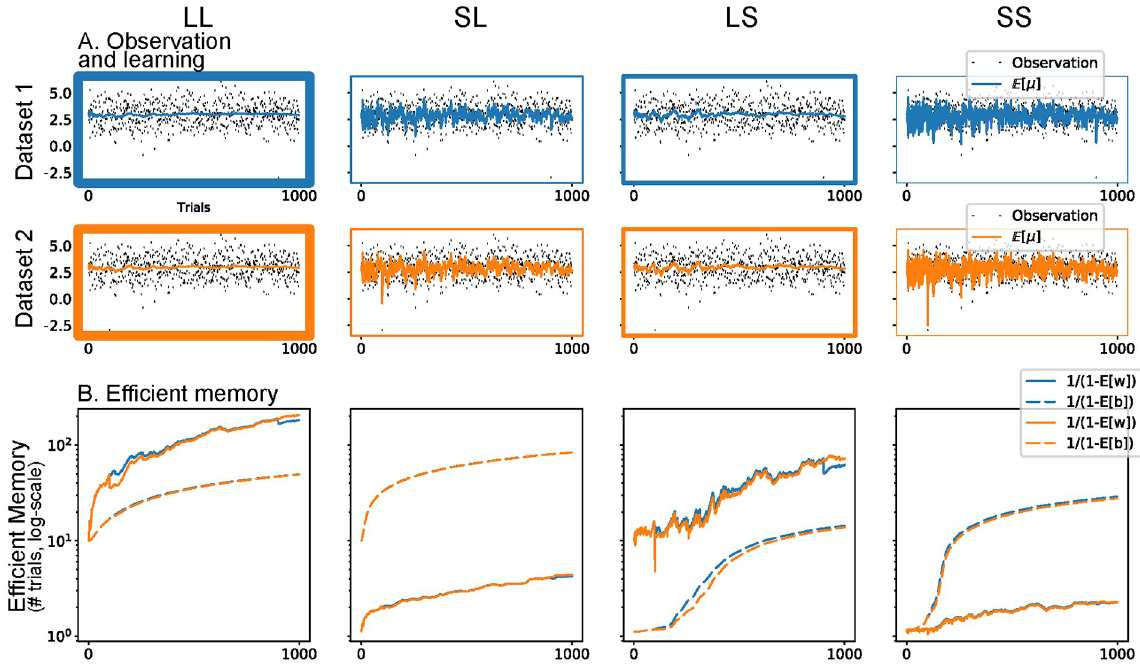
Fig 6. HAFVF predictions after an isolated unexpected event. The figure is similar to Fig 5. Here, the winning model was the one with a high memory on the first and second levels. The figure is structured as Fig 5, and we refer to this for a more detailed description.